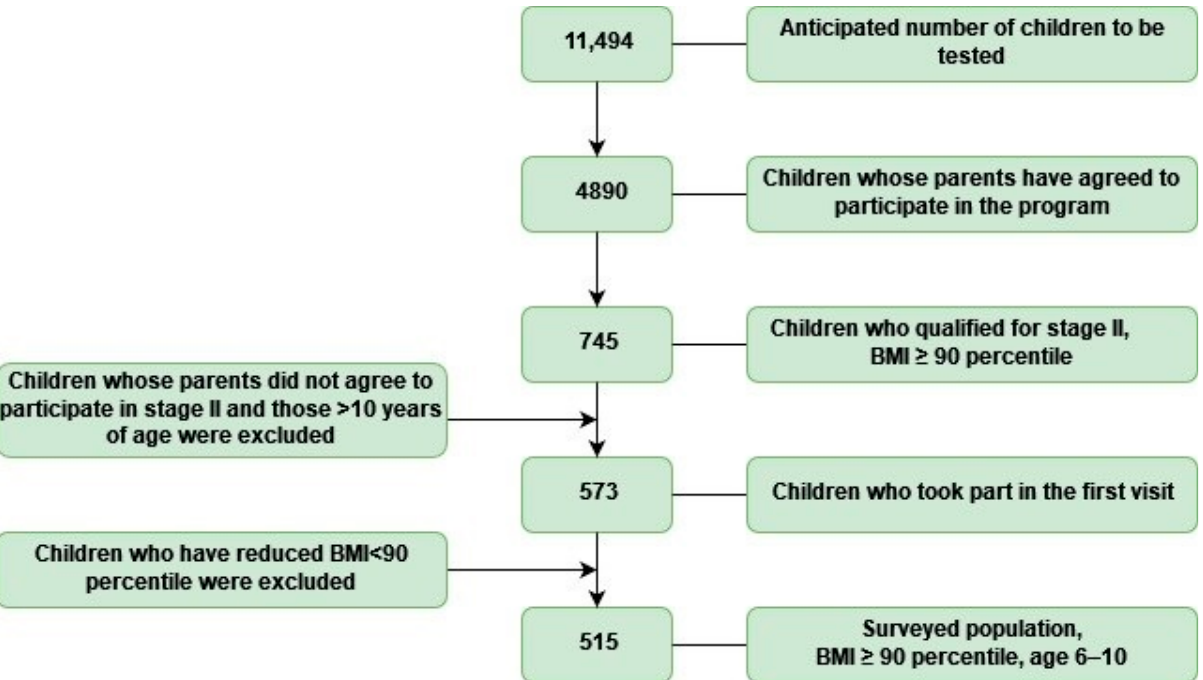
Figure 1. Diagram showing how children qualified for the study